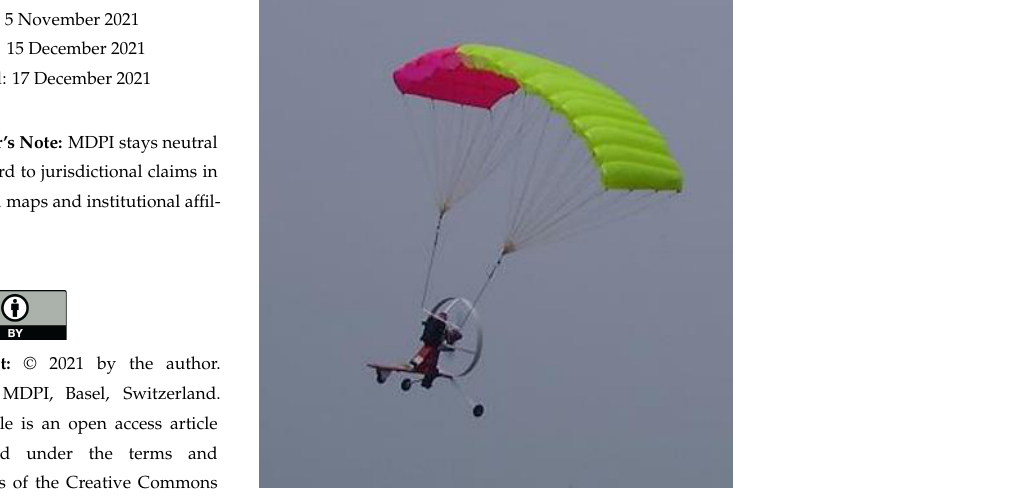
Figure 1. Powered parachute flying vehicle.